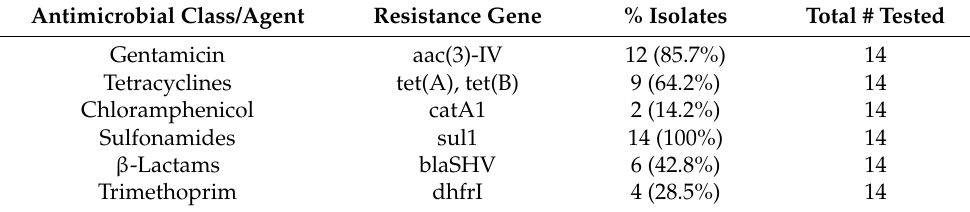
Table 6. Comparison for the detection of resistance genes from samples using PCR.